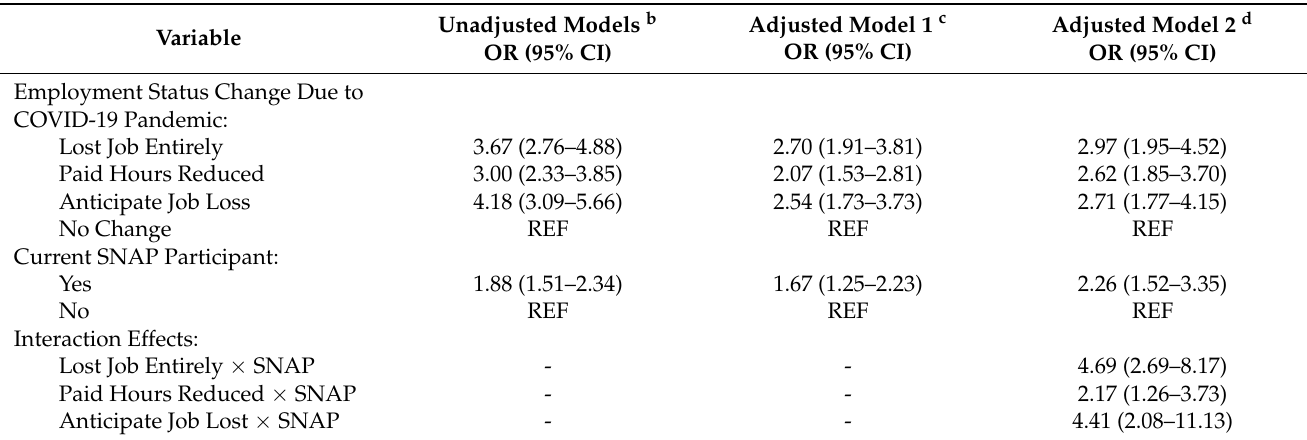
Table 2. Associations between Employment Status Change during COVID-19 Pandemic, SNAP Participation, and Low Food Security a .